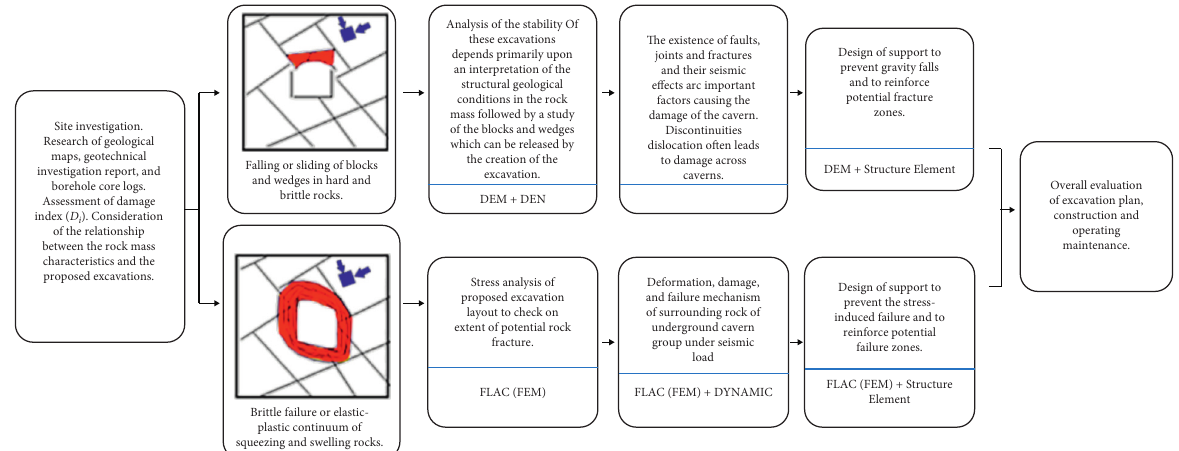
Figure 2: Flowchart of rock mechanics modeling techniques of